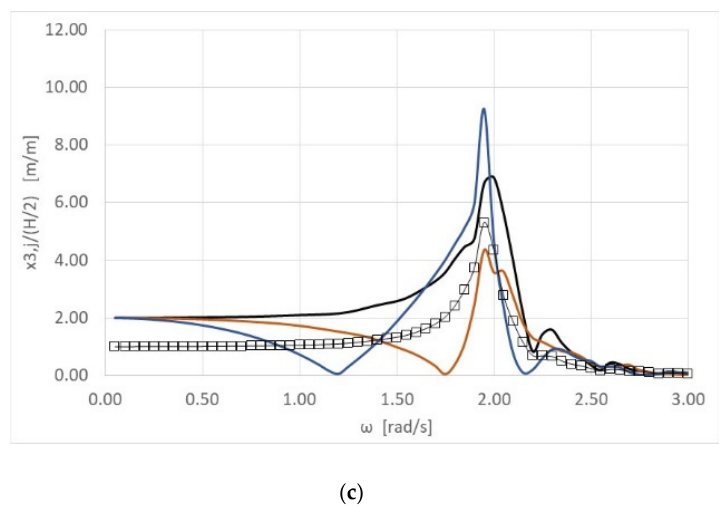
Figure 4. Dimensionless heave displacement of the 3rd WEC, j = 3, of the parallel to the wall array, against ω , for three different examined distances from the vertical wall and three wave heading angles. Comparisons are made for the heave displacements of the same converter of the array without the presence of the breakwater: ( a ) θ = 0°; ( b ) θ = 45°; ( c ) θ = 60°.